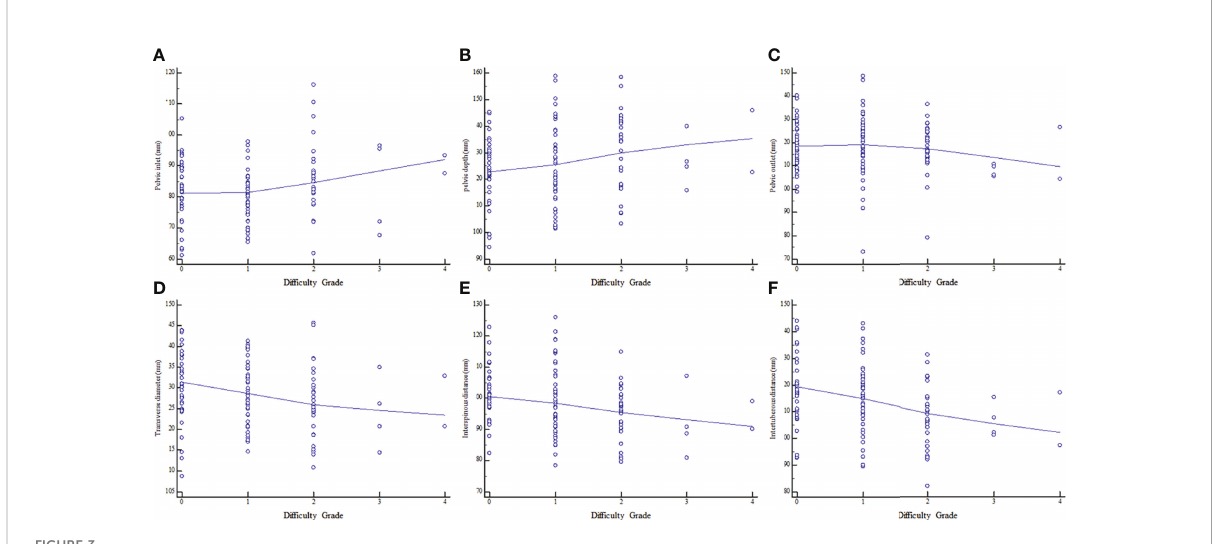
FIGURE 3 Relationships between surgical dif fi culty grade and MRI-based pelvimetry indexes. (A) Pelvic inlet. (B) Pelvic depth. (C) Pelvic outlet. (D) Transverse diameter. (E) Interspinous distance. (F) Intertuberous